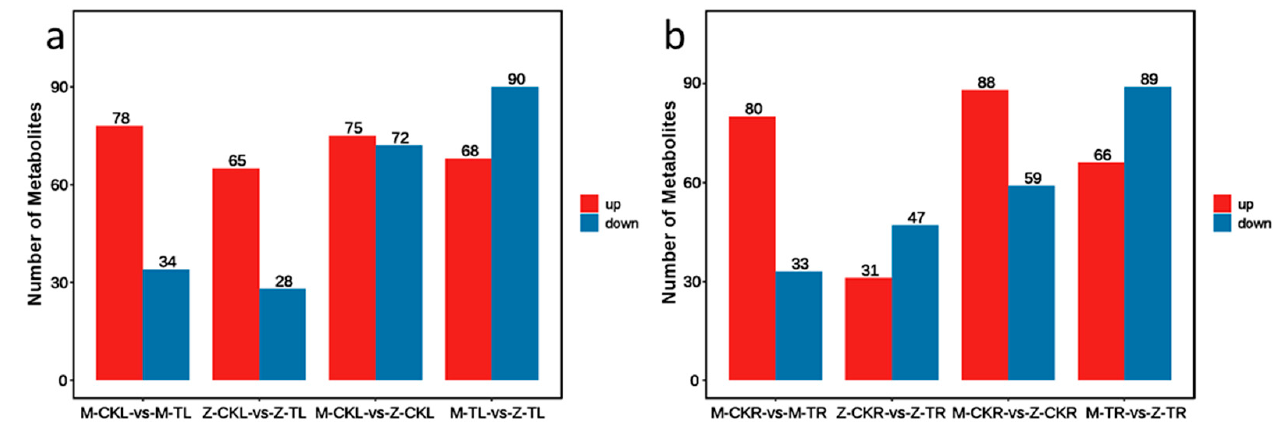
Figure 6. The number of DAMs in leaves and roots of different combinations. ( a ) The number of DAMs in leaves of different combinations. ( b ) The number of DAMs in roots of different combina- tions.